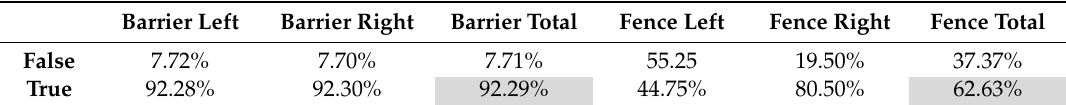
Table 5. Quality of auto-classification of images by the ANN. Barrier Left Barrier